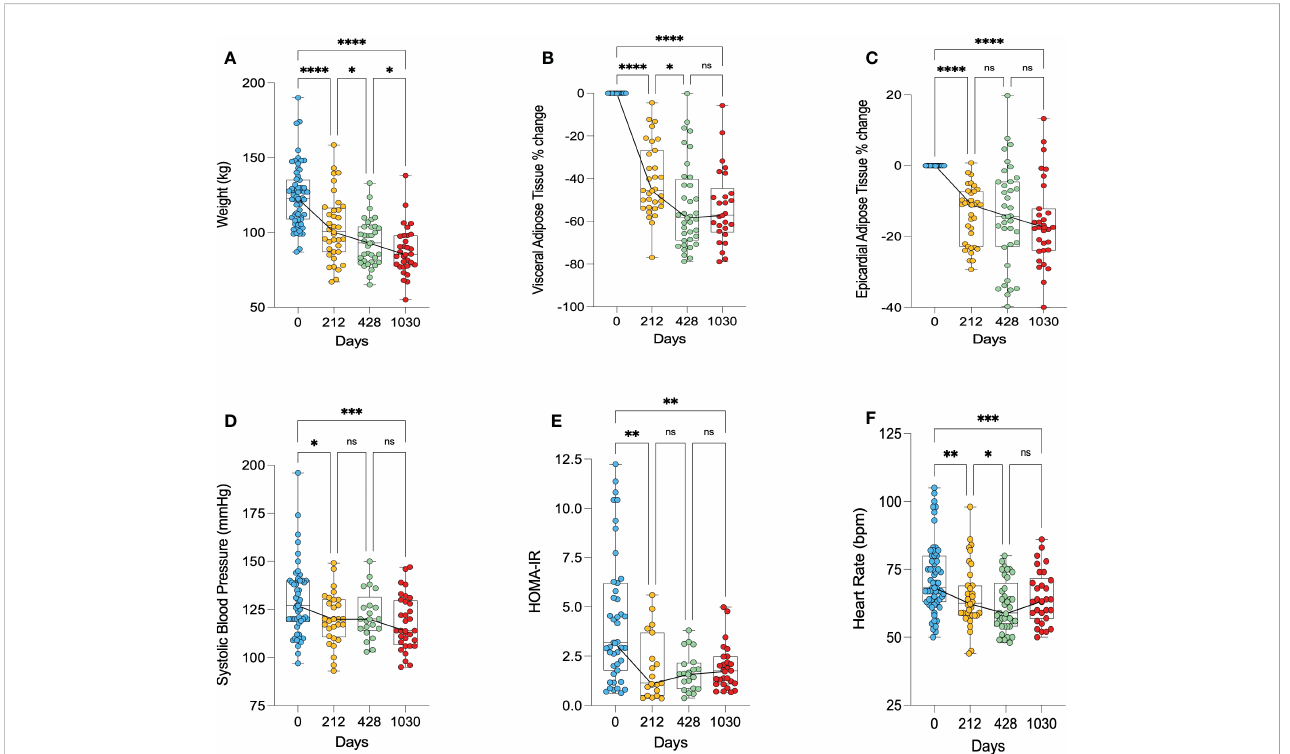
FIGURE 2 Anthropomorphic changes following bariatric surgery. (A) – change in weight, (B) – percentage change in visceral adipose tissue, (C) – percentage change in epicardial adipose tissue, (D) – change in systolic blood pressure, (E) – change in HOMA-IR as a marker of insulin resistance, (F) – change in heart rate. HOMA-IR, homeostatic model assessment of insulin resistance. * < 0.05, ** < 0.01, ***<0.001, ****<0.0001, ns, Non signi fi